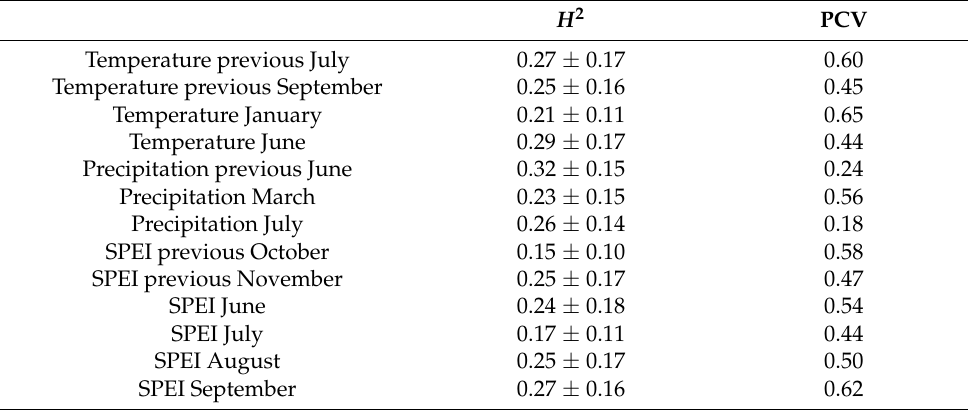
Table 4. Coefficients or broad-sense heritability ( H 2 ± standard error) and provenance coefficient of variation (PCV) for the responses of relative additional basal area increment (BAI) to meteorological variables: monthly mean temperature, precipitation sums and precipitation evapotranspiration indices (SPEI). Only the variables showing heritability above 0.15 are